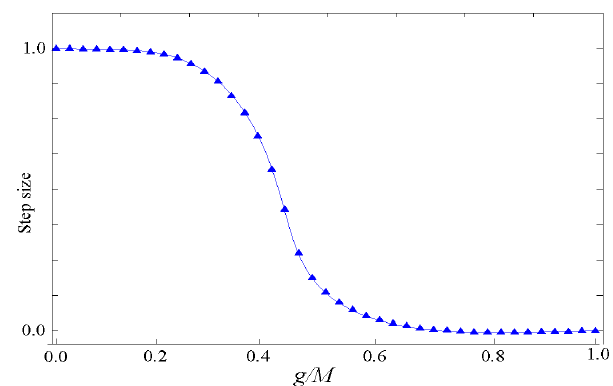
Figure 2. Step variations curve at a = 5.